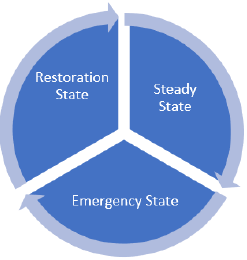
Figure 1. Operation of modern power systems.